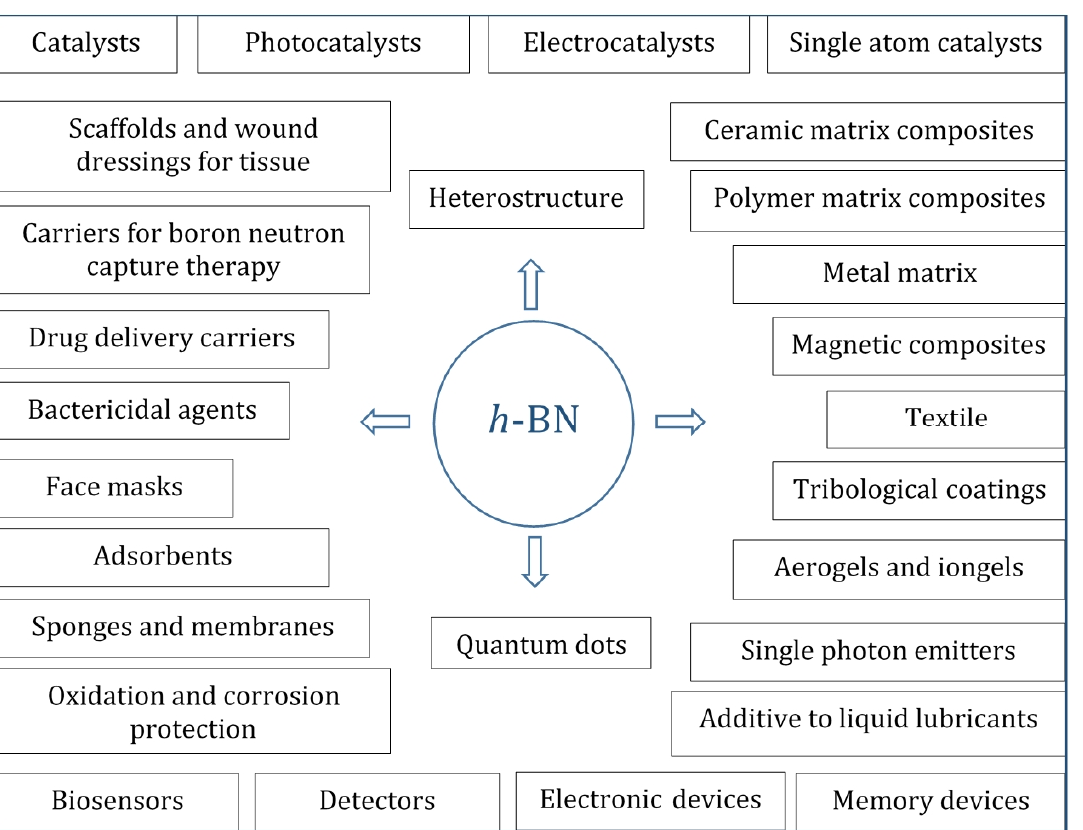
Figure 2. Applications of h -BN